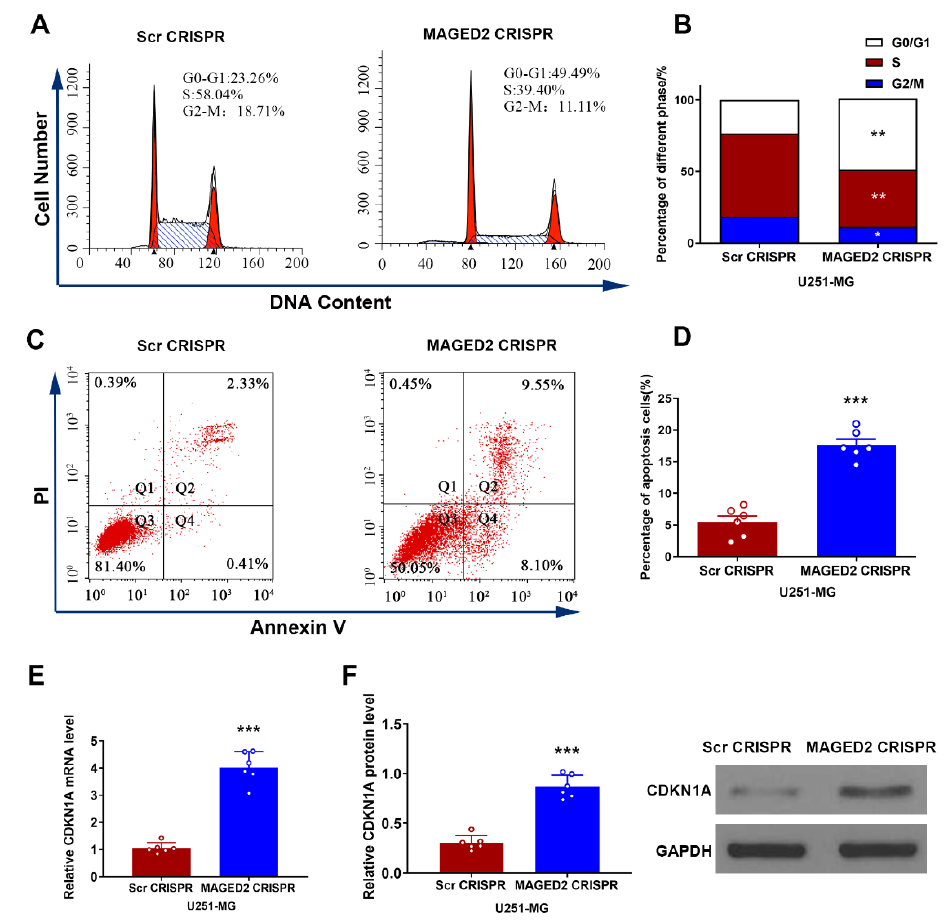
Figure 7. In glioma U251-MG cells, MAGED2 regulates the cell cycle, apoptosis, and CDKN1A expression levels. ( A – D ) Flow cytometry of the cell cycle distribution ( A , B ) and apoptosis ( C , D ) level of U251-MG cells transfected with MAGED2 CRISPR or Scramble CRISPR. ( E – F ) The mRNA ( E ) and protein ( F ) expression levels of CDKN1A detected by Western blotting and qRT-PCR after transfection with MAGED2 CRISPR or Scramble CRISPR. * p < 0.05, ** p < 0.01, and *** p < 0.001 compared with the Scramble CRISPR group; n = 6/group.